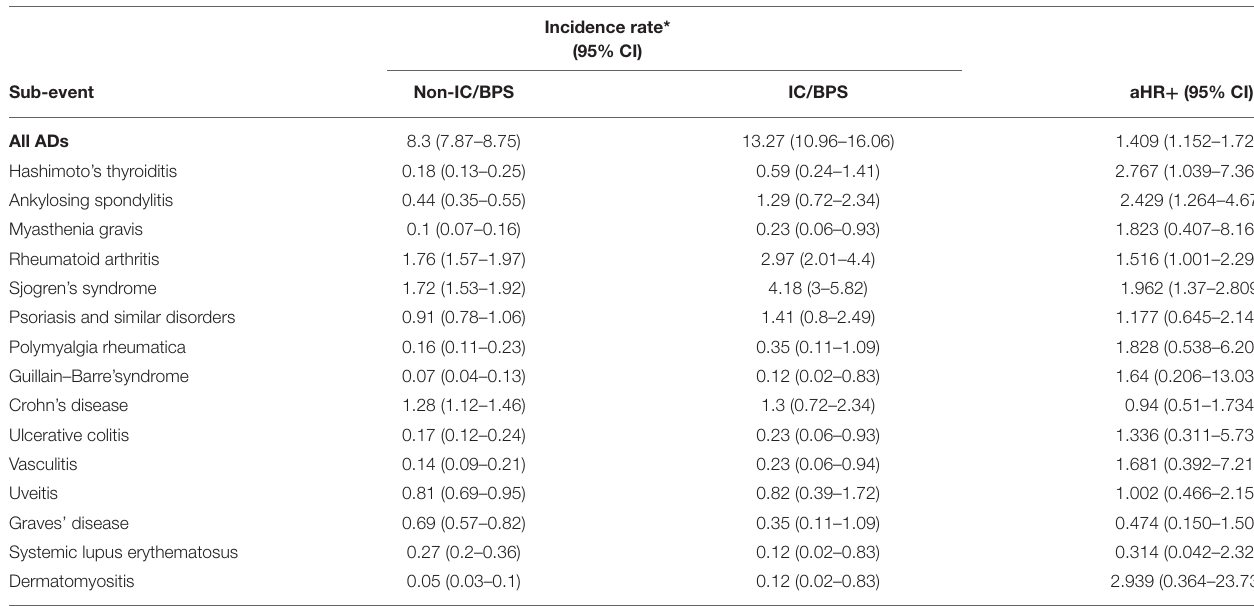
TABLE 5 | Sub-event of ADs in study